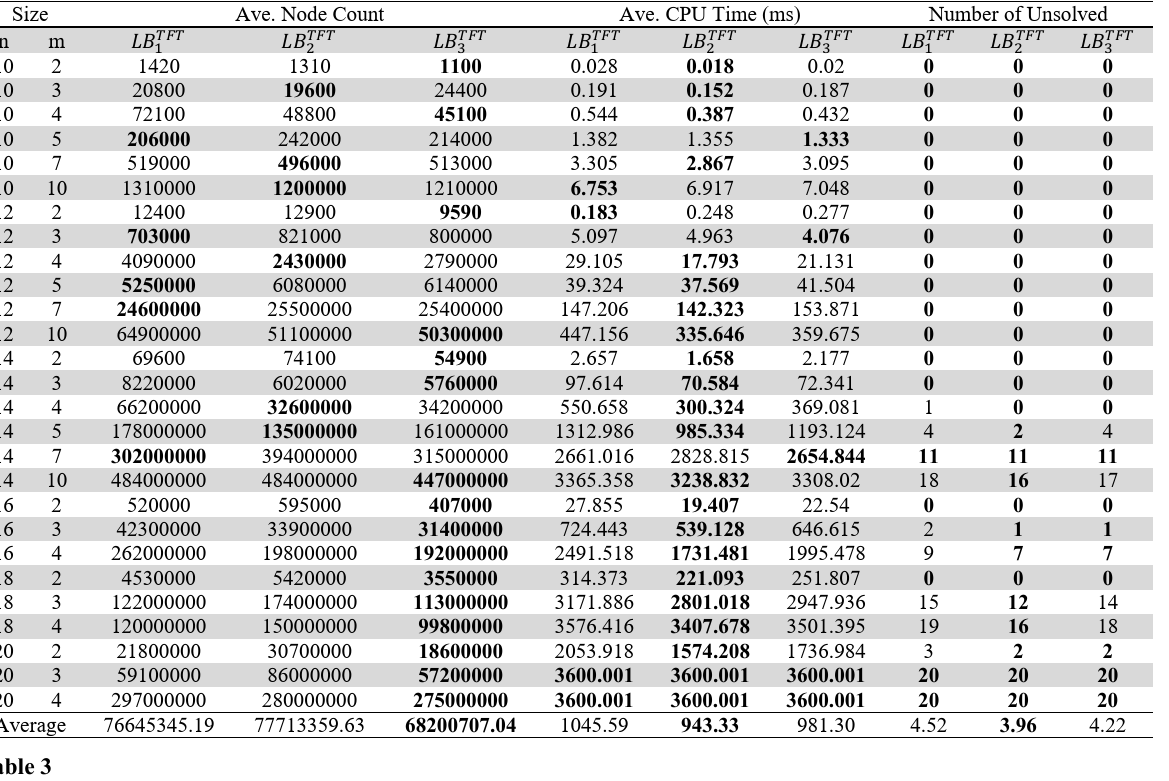
Comparison of the variations of 𝐿𝐵 (cid:3021)(cid:3007)(cid:3021) – Database